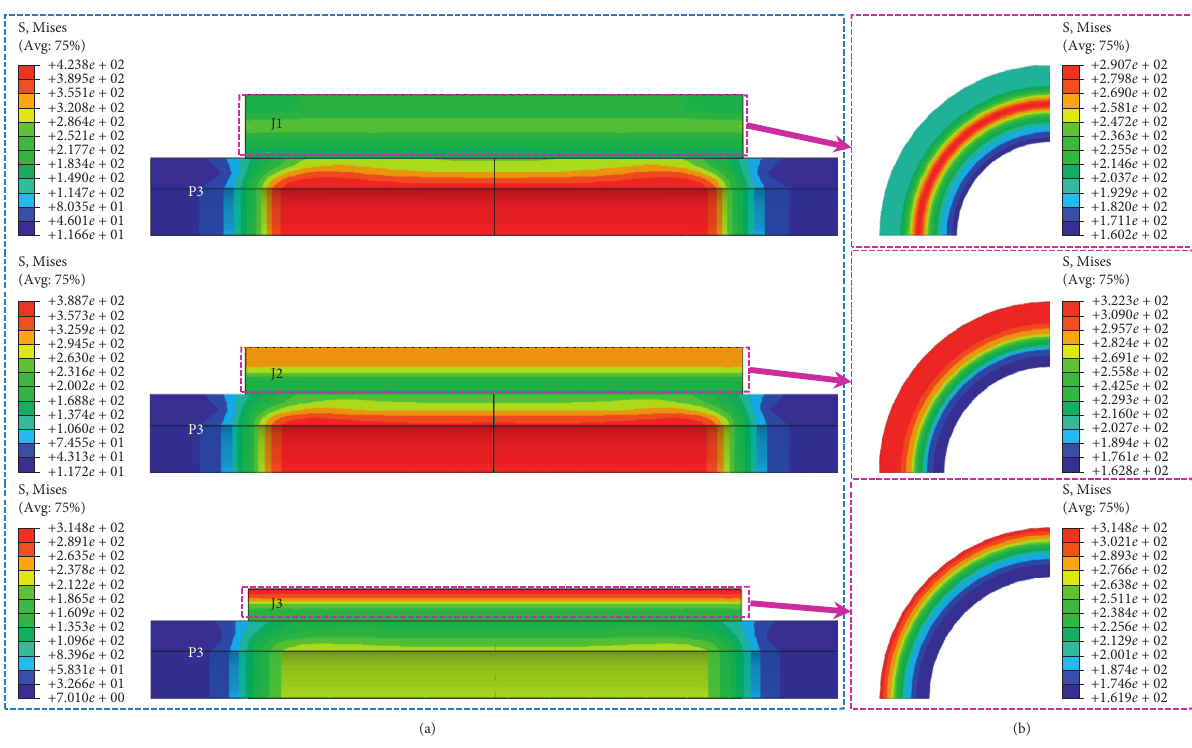
Figure 8: (a) Contour maps of σ equ in J1-P3, J2-P3, and J3-P3 at room temperature, and (b) Mises equivalent stress contour in the cross- section of the NiTiNb joint at room temperature.